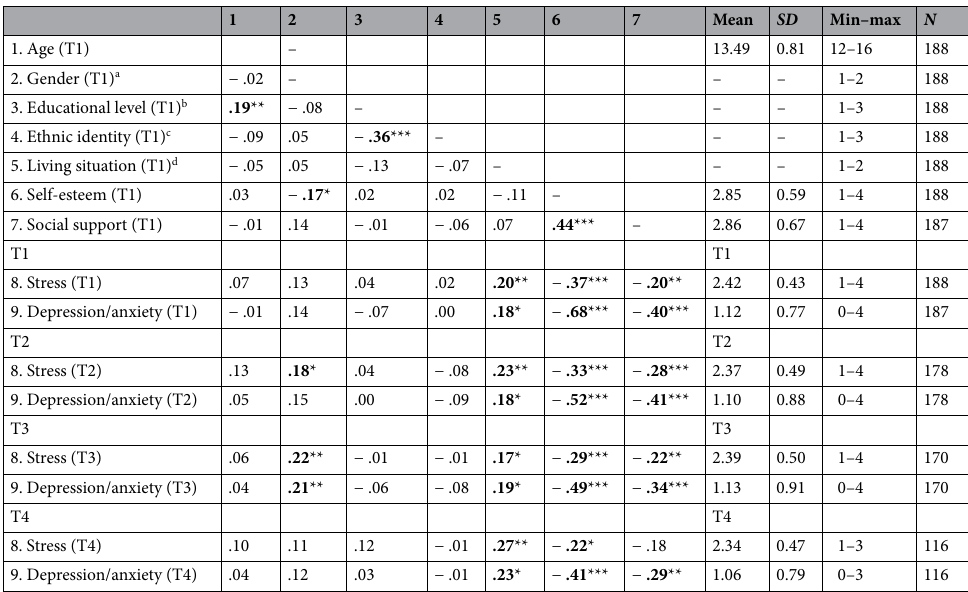
Table 1. Correlations and descriptive statistics (means, standard deviations, ranges, and sample sizes) for study variables. Significant correlations are bolded. For gender, educational level, ethnic identity, and living situations, Spearman correlations were conducted. *** p < .001; ** p < .01; * p < .05. a 1 = male, 2 = female. b 1 = prevocational educational level, 2 = prevocational / senior general educational level, 3 = senior general / preuniversity educational level. c 1 = Western, 2 = mixed Western-non-Western, 3 = non-Western. d 1 = living